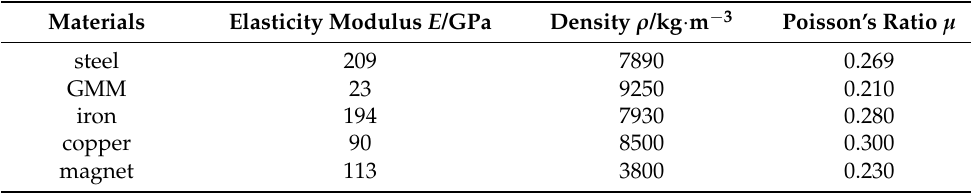
Table 2. Material parameters.